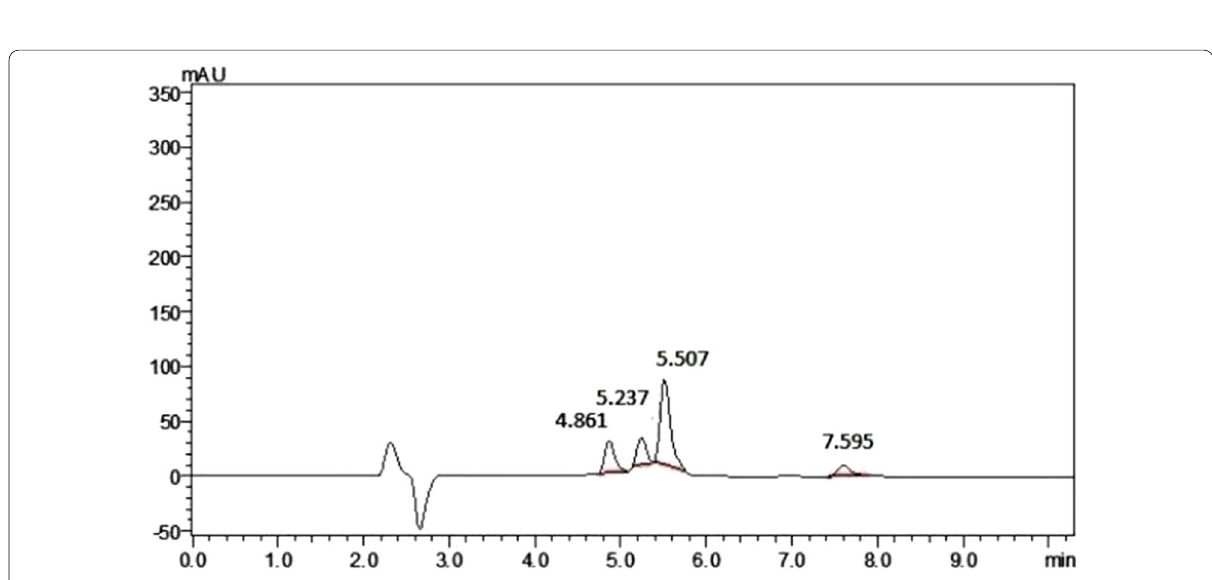
Fig. 5 Base degradation in which Mupirocin calcium undergoes degradation in presence of methanolic 0.1 N NaOH at 60